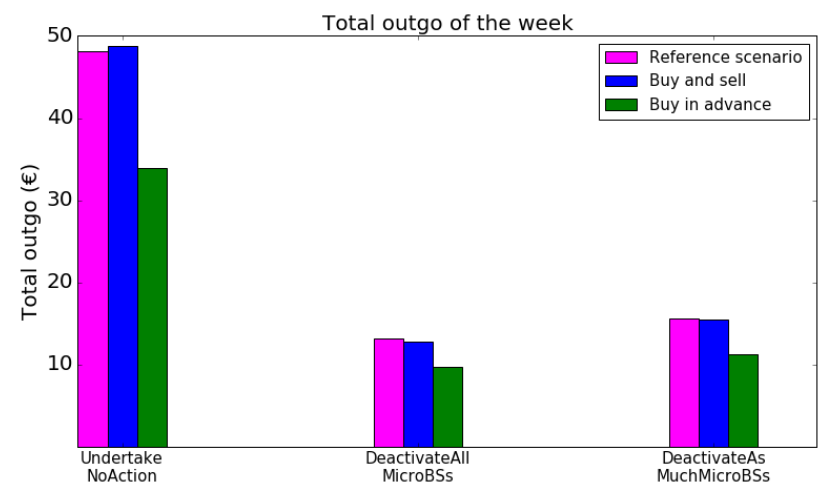
Figure 8. Total outgo obtained using energy- and cost-reducing actions of Strategy